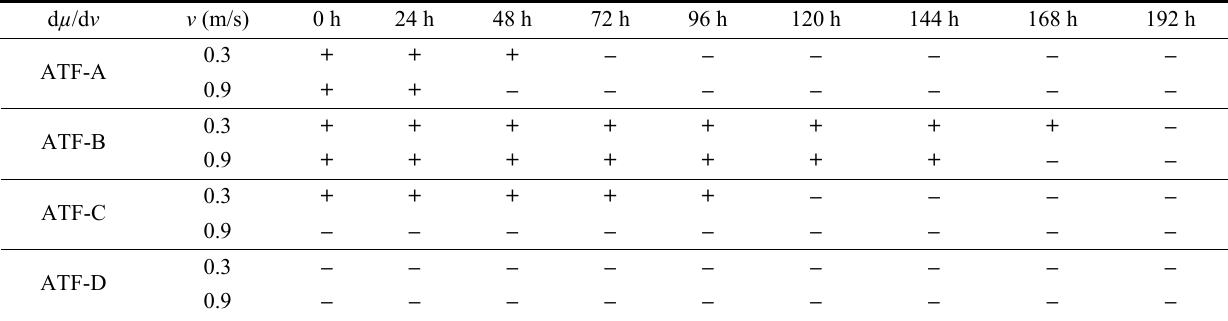
Fig. 2 µ - v curves after endurance test for ATFs A, B, C, and D. Table 2 d µ /d v at 0.3 and 0.9